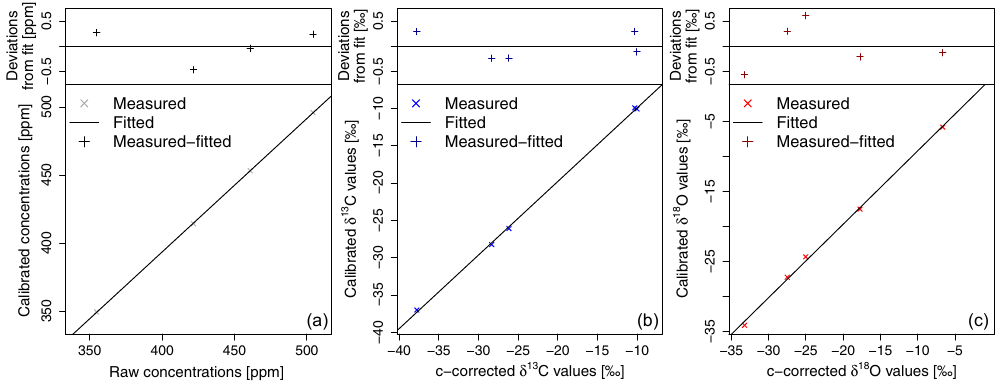
Figure 5. Linear calibrations for concentration (a) and concentration-corrected δ 13 C and δ 18 O (b, c) respectively.